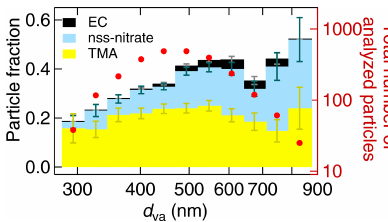
Figure 19. Size-resolved aerosol composition of the ALABAMA particle types during the southern air mass period. The figure repre- sents the cumulative particle fraction of EC-containing (black), nss- nitrate-containing (light blue), and TMA-containing (yellow) parti- cles, as well as the total number of analyzed particles per bin (red). Uncertainty analysis is given in Sect.